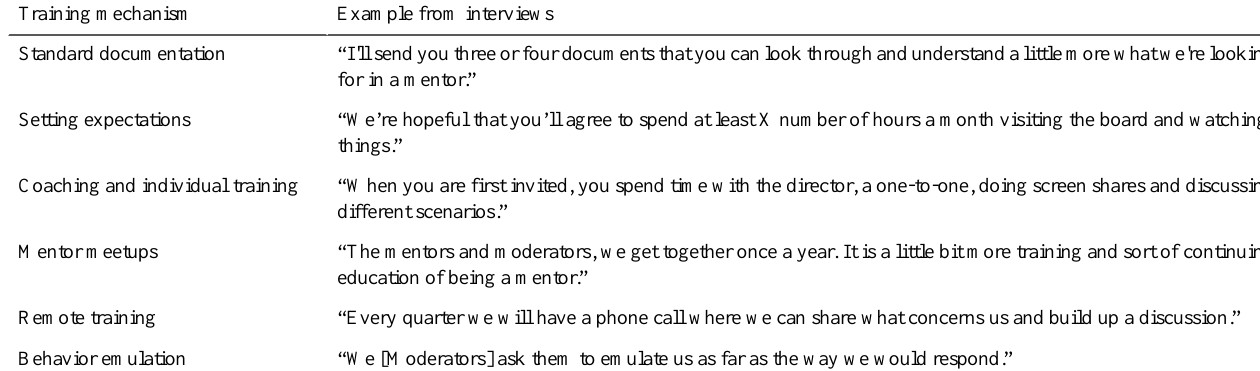
Table 1. Training mechanisms for mentors.